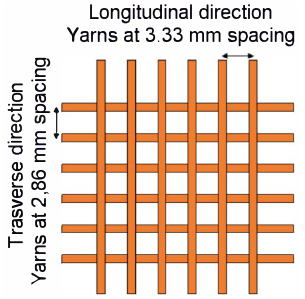
Figure 1. Jute fabric mesh opening.